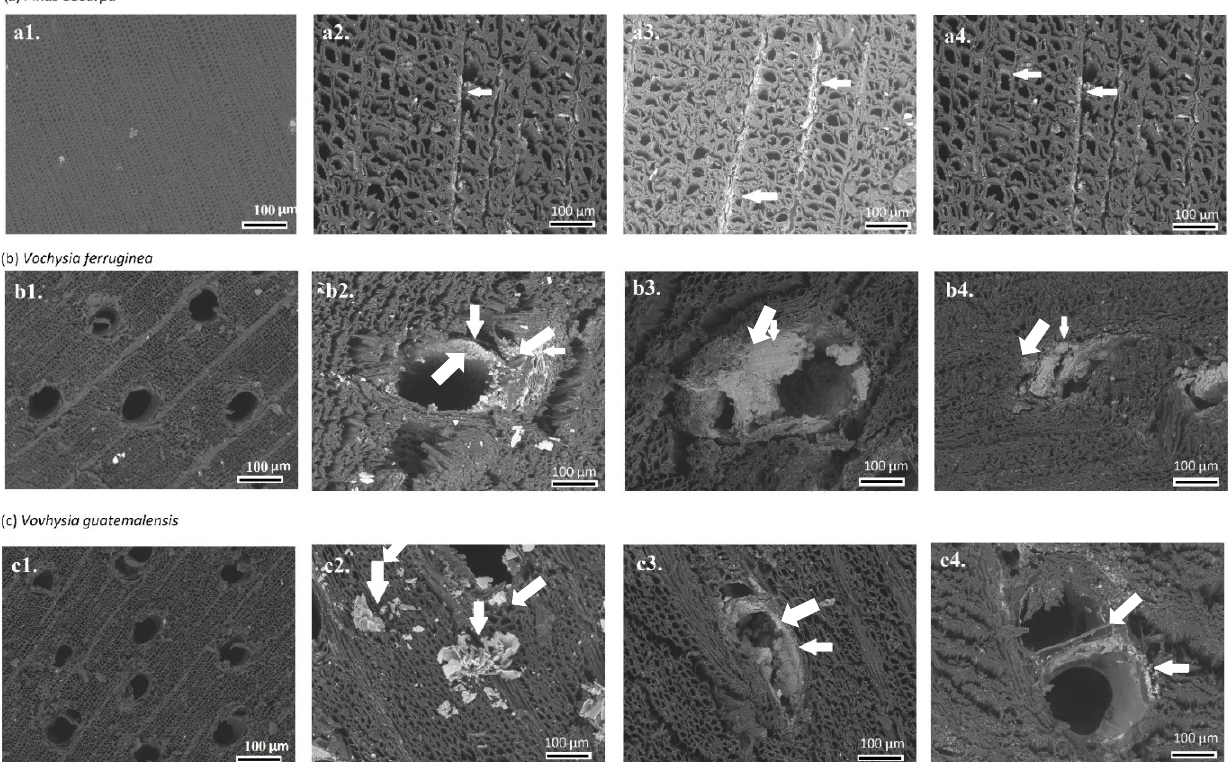
Figure 2. Scanning electron microscope ( SEM) images showing Fe 3 O 4 NPs formation of magnetic wood with three different immersion times in ammonium (1: untreated, 2: 12 h, 3: 24 h; 4: 48 h) in three tropical wood species ( a – c ) from fast-growth plantations in Costa Rica. Note : The white arrow indicates the formation of Fe 3 O 4 NPs in the rays, fibers or vessels.